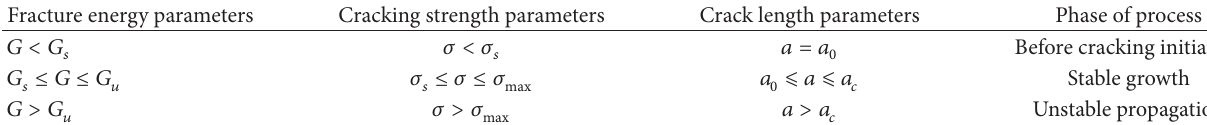
Table 1: The indexes for cracking process of AIJ.